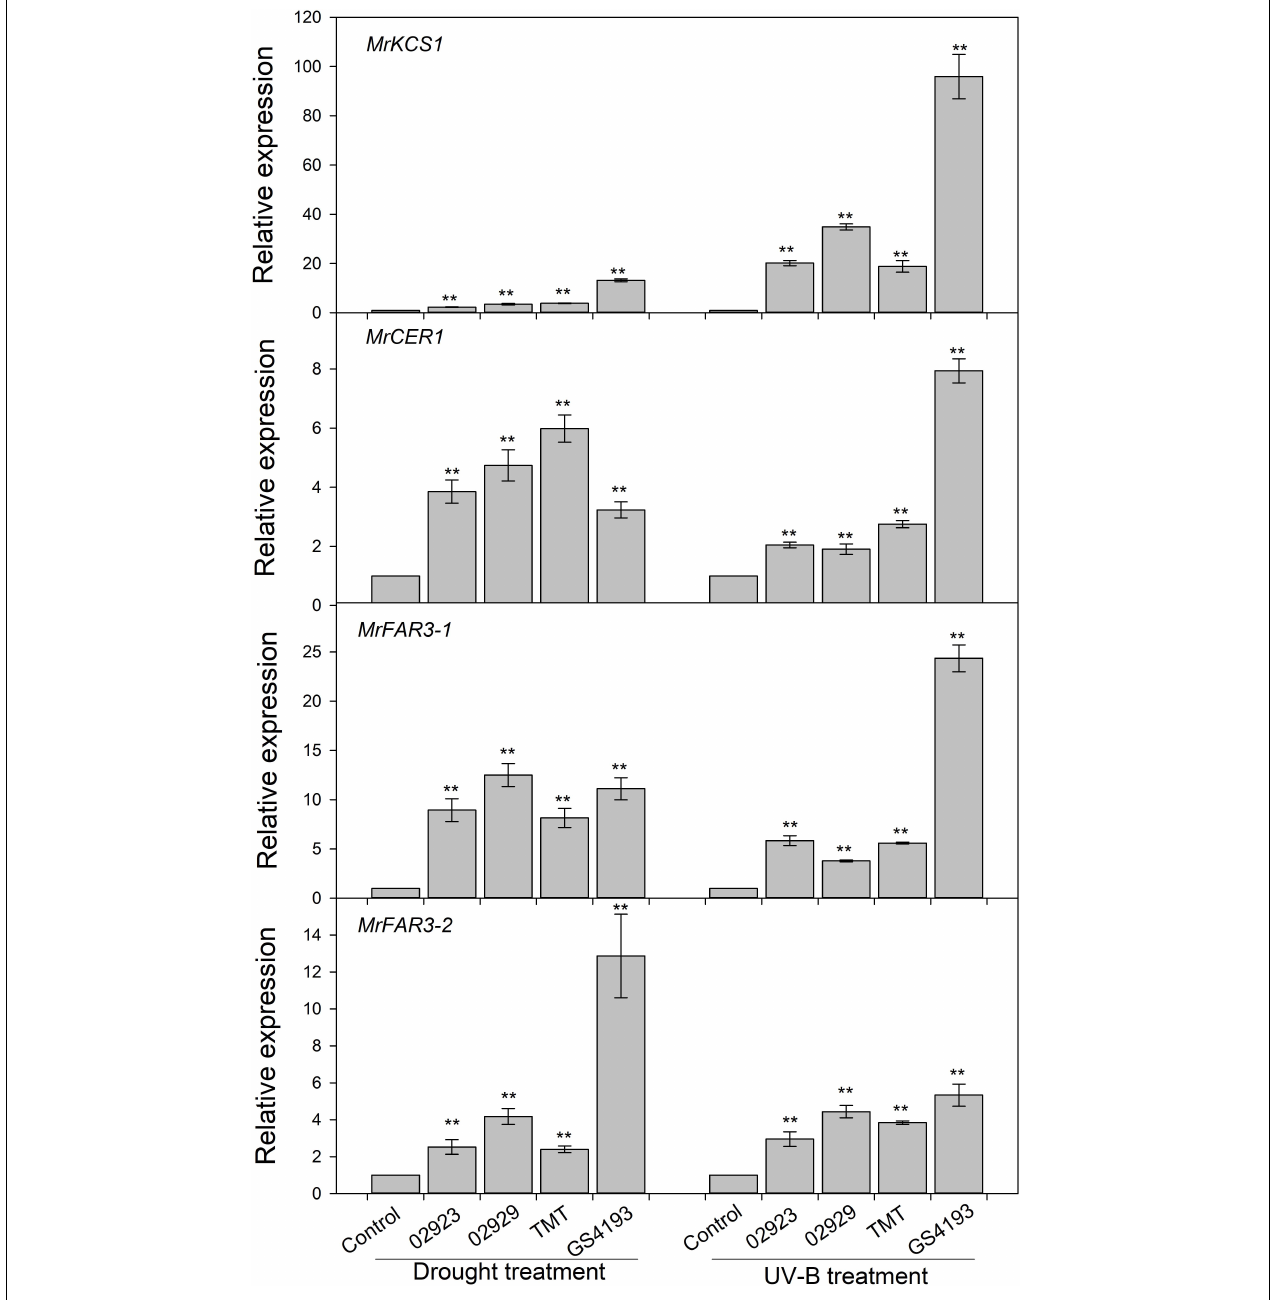
FIGURE 5 | Relative expressions of four wax genes under drought and enhanced UV-B treatments. ** represented significance when compared with the control (the control for each cultivar was adjusted to one) using Student’s t